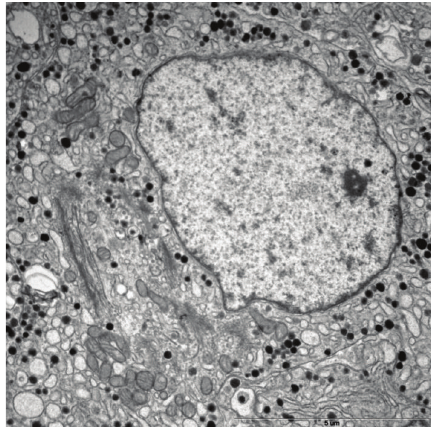
Figure 2: Ultrastructural features of sparsely granulated corti- cotroph adenoma (original magnification, 9700x). The cell has well developed Golgi complexes, dilated endoplasmic reticulum, and sparse, variable in shape and electron density secretory granules that measure 200 to 250 nm in diameter. Perinuclear bundles of cytokeratin filaments are absent.